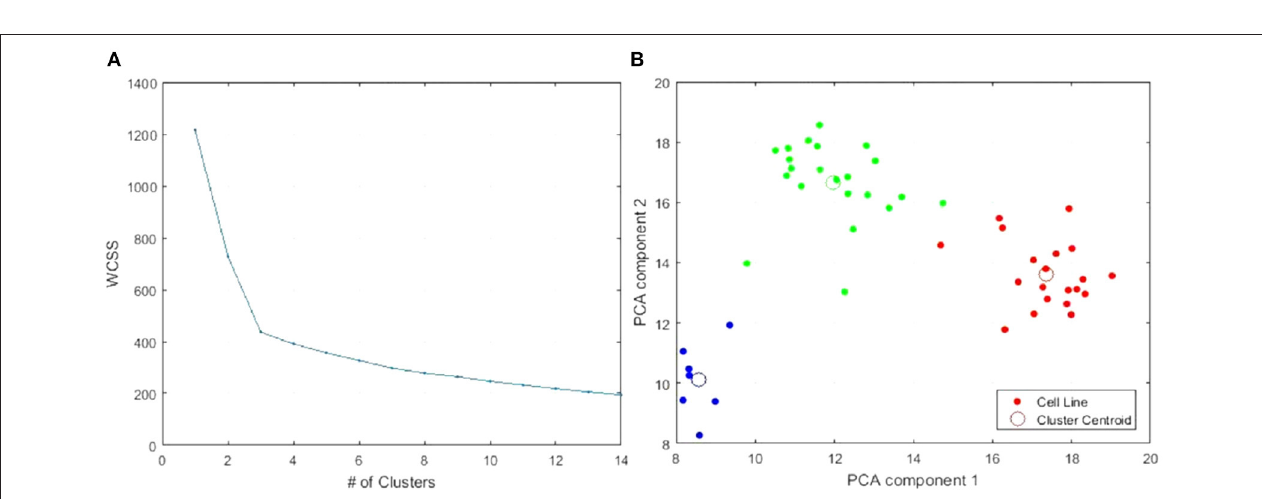
FIGURE 6 | Clustering of the 49 CCLE skin cancer tumors using the top 15 genes only. (A) WCSS error. (B) PCA plot of 3-clusters using only the top 15 genes: Cluster 1, Cluster 2, Cluster 3. The colors are used to distinguish each Cluster. This color scheme is carried through on Table 2 and 5 to make it easy to distinguish each